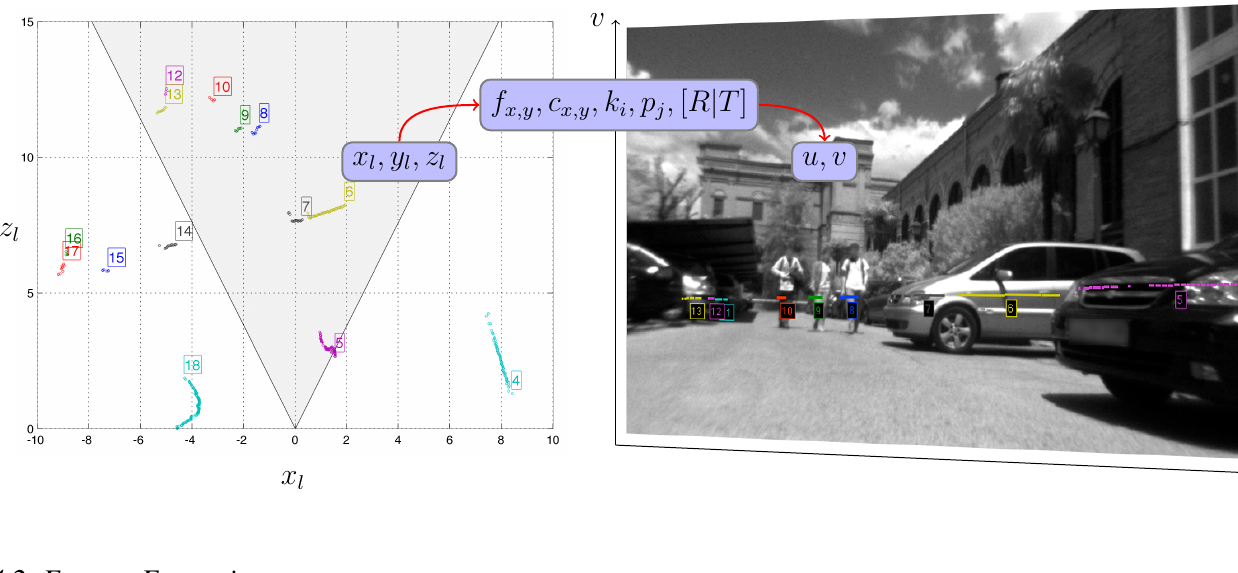
Figure 2. Projection of laser segmented clusters to the image plane using the calibration parameters. In the left image, the shaded area indicates the field of view of the camera. The color and number of each cluster are the same in both